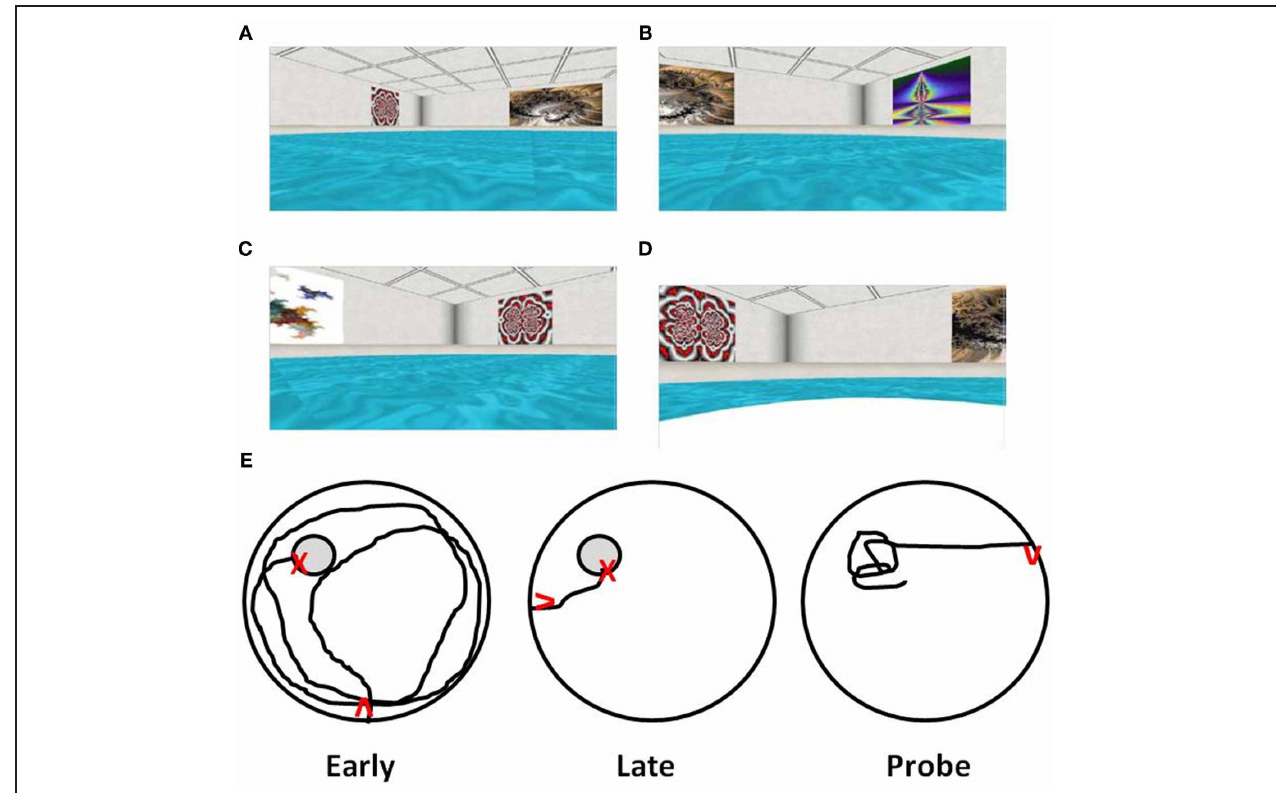
find the hidden target (gray circle) during the first training trial of acquisition training (Early), direct path to target of later training trial indicating learning (Late), and a probe trial with path focused on the location that had contained the target (Probe). Red arrows indicate start position/orientation) and red X’s indicate the end point of